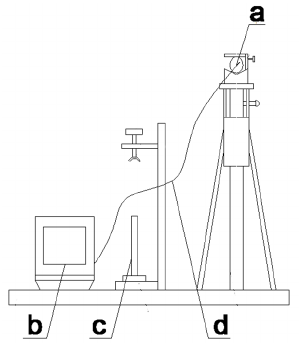
Figure 4. A micron ‐ level crack microscopic dynamic monitoring device; ( a ) camera lens, ( b ) image processor, ( c ) axis of rotation, ( d ) optical fiber.